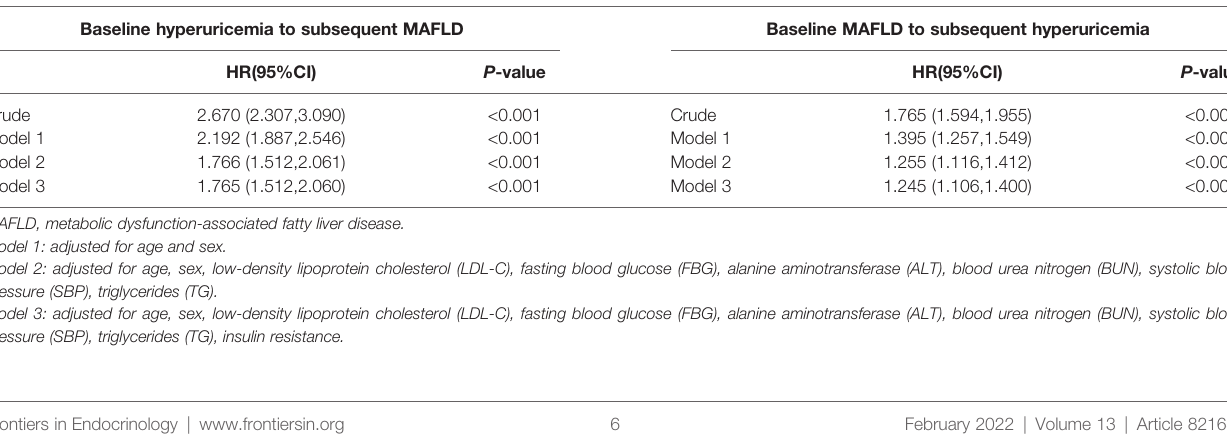
TABLE 3 | The association between hyperuricemia and MAFLD by the Cox regression in the longitudinal cohort study. Baseline hyperuricemia to subsequent MAFLD